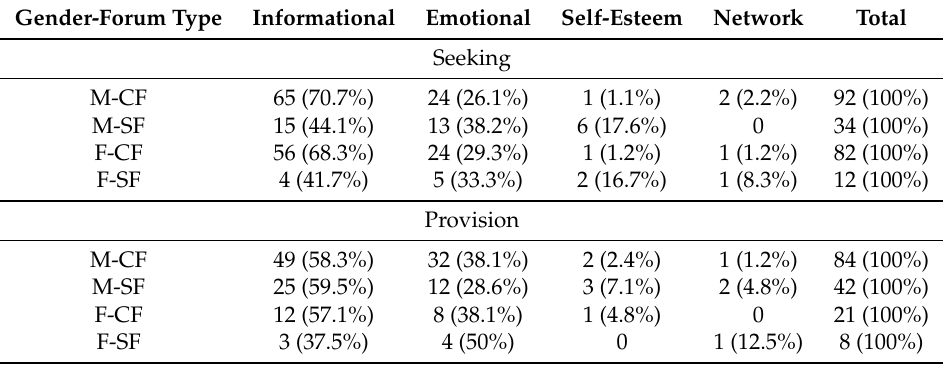
Table 8. Support type, gender, and forum type. M = Male; F = Female (Unknown gender is excluded).